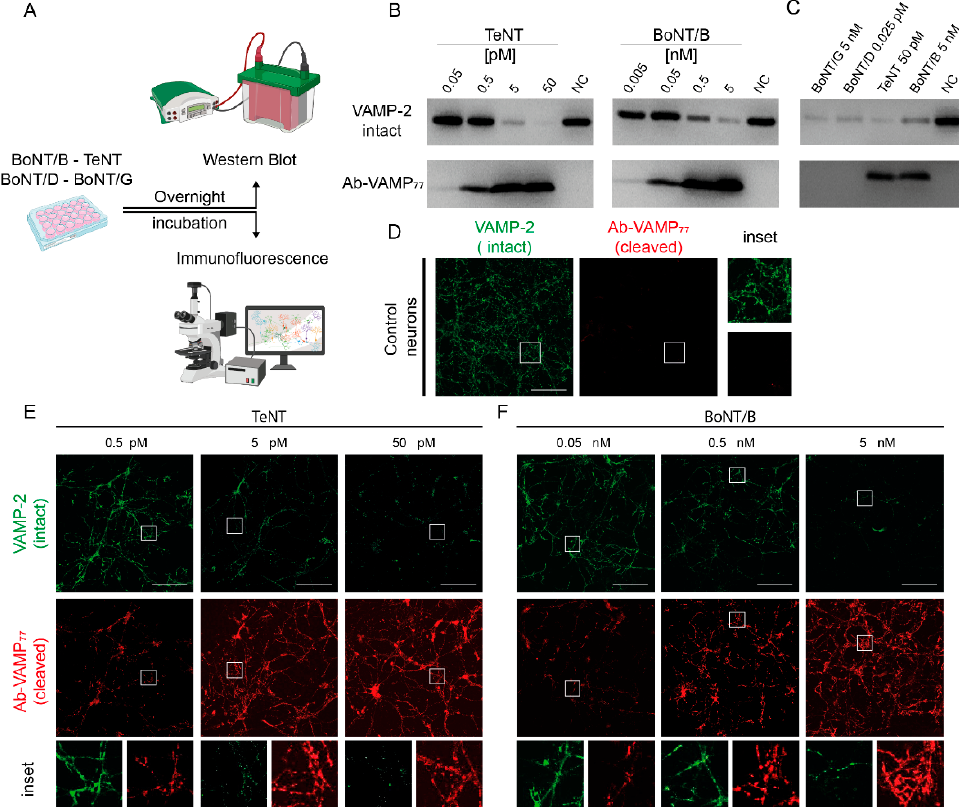
Figure 2. The Ab-VAMP 77 polyclonal antibody detects VAMP-1/2 cleavage by TeNT and BoNT/B in neuronal culture with high efficiency and toxin selectivity. ( A ) Scheme showing the experimental readout used to evaluate the specificity of Ab-VAMP 77 in rat CGNs. ( B ) Representative Western blotting showing the high sensitivity of Ab-VAMP 77 compared to a conventional antibody at low TeNT ( left ) and BoNT/B ( right ) concentrations. The NC samples are control neurons not treated